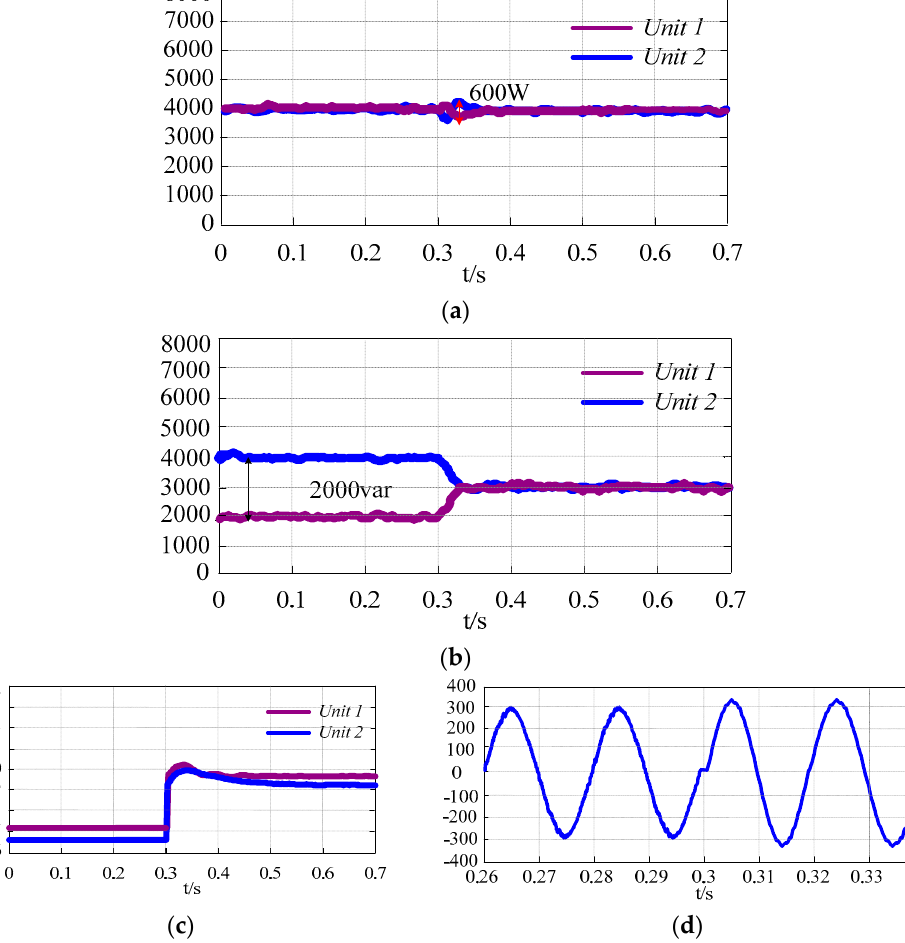
Figure 8. Simulation results of proposed method in simulation I. ( a ) The active power (W); ( b ) The reactive power (var); ( c ) The RMS value of inverter output voltage (V); ( d ) The inverter output voltage (V).